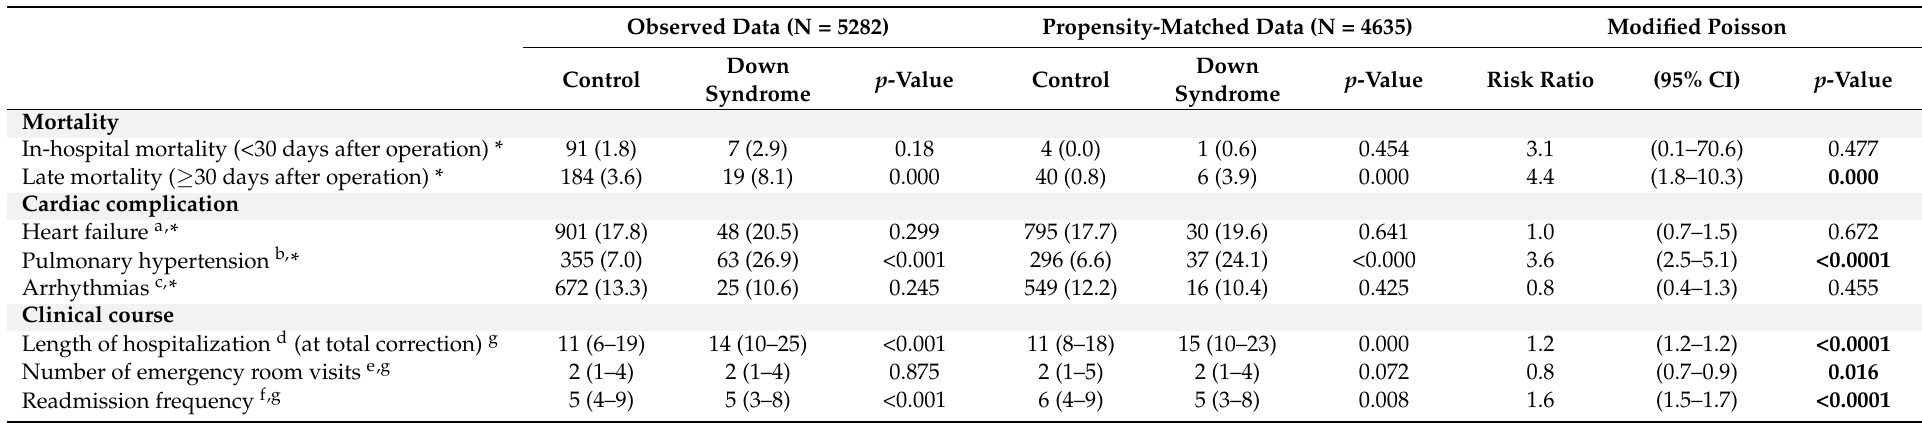
Table 4. The postoperative mortality and outcomes for congenital heart disease in patients with and without Down